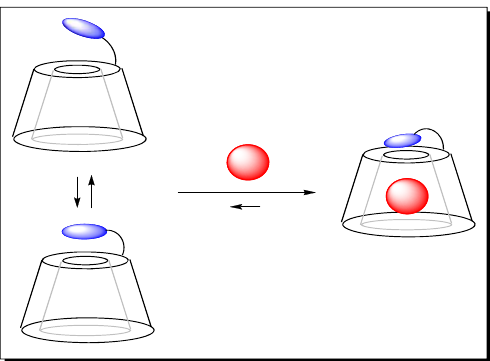
Figure 9. Inclusion phenomena of a guest in CDs molecules. Reproduced with permission from Reference [52], published by Bentham Science, 2009.